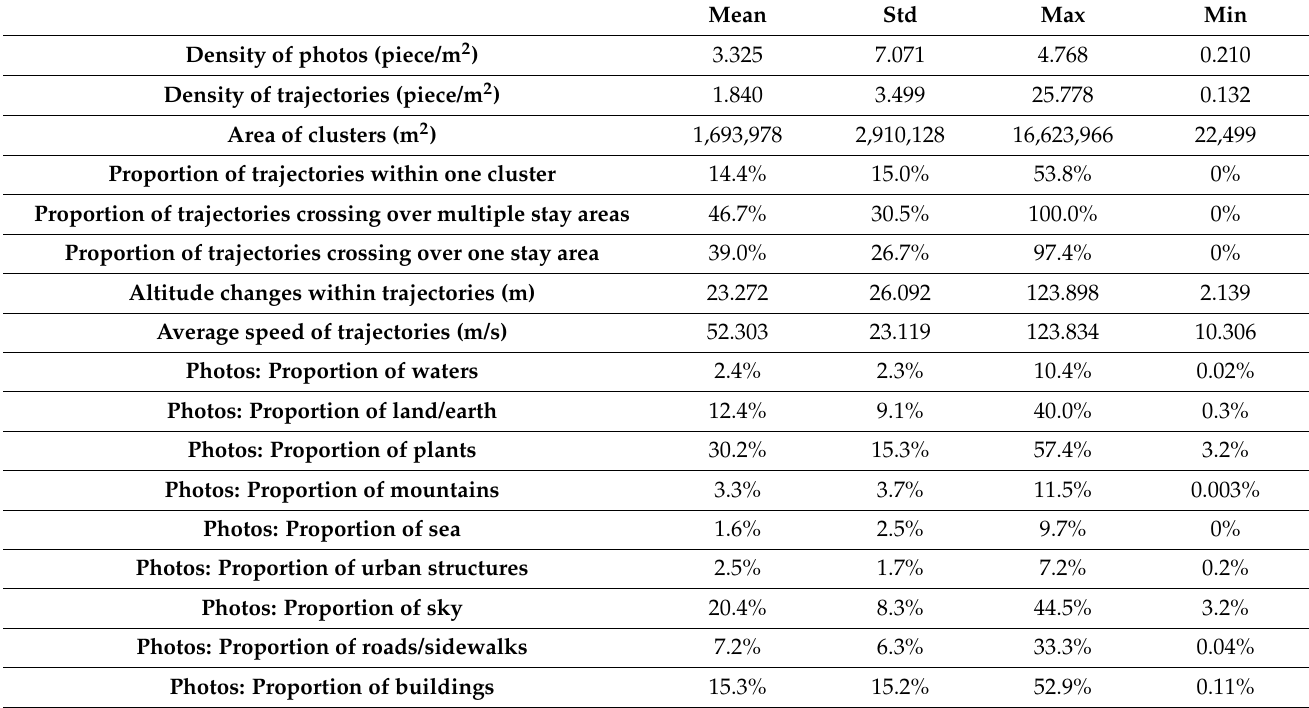
Table 1. Characteristic of 17